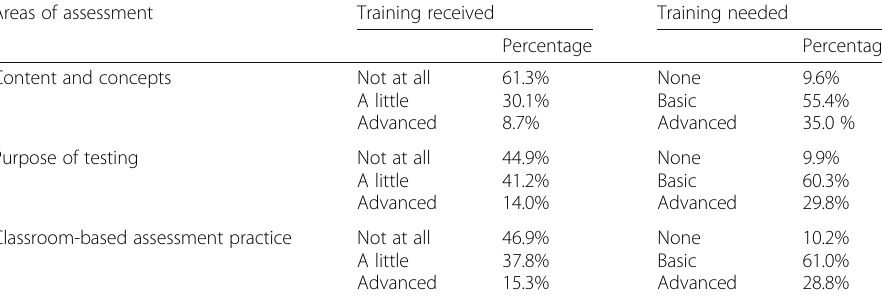
Table 5 Overall trend of assessment